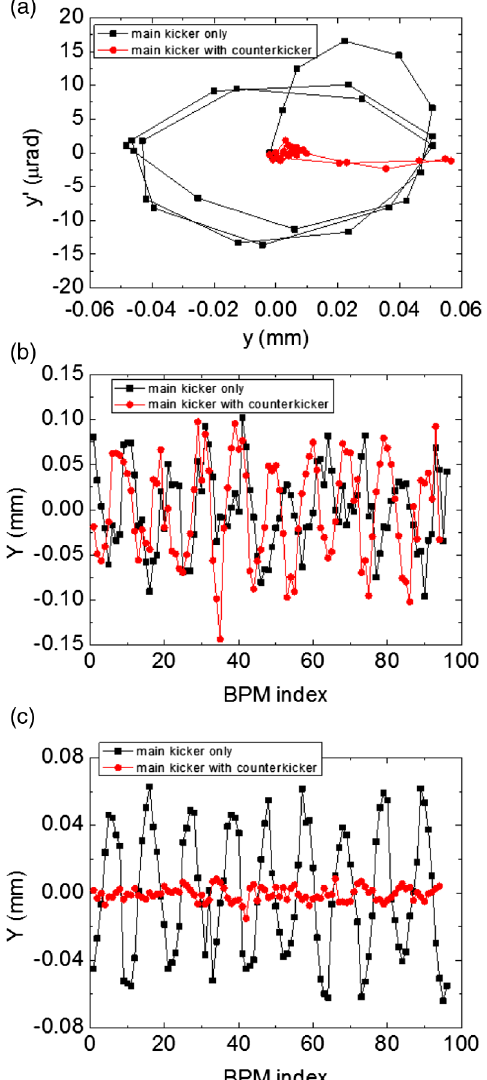
FIG. 8. (a) Measured phase space beam motion at 2A BL (magnetic spectroscopy beam line) with and without a counter- kicker. (b) Measured beam oscillation along all BPMs for the fourth turn after the kicker was turned on: oscillation was not suppressed while the kicker was on. (c) Measured beam oscil- lation along all BPMs after the kicker was